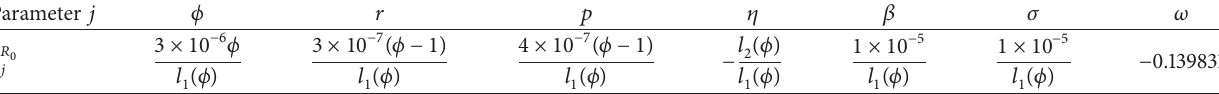
Table 2: Sensitivity indices of 𝑅 0 to all parameters.